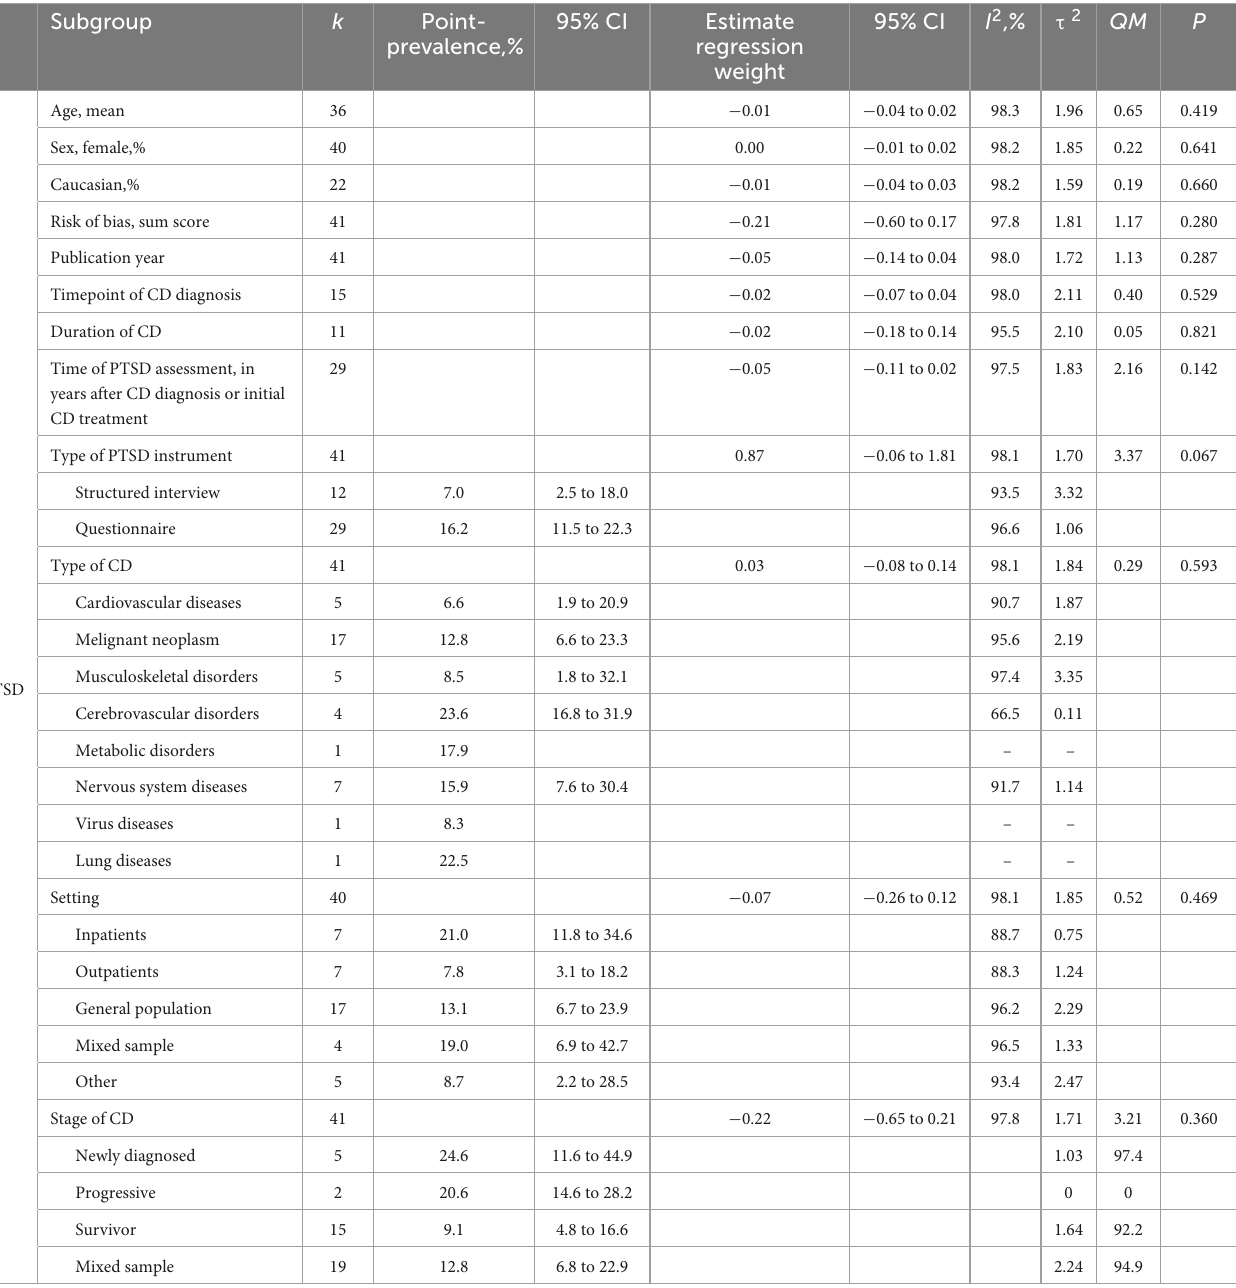
TABLE 1 Meta-regressions of point prevalence of PTSD in people with